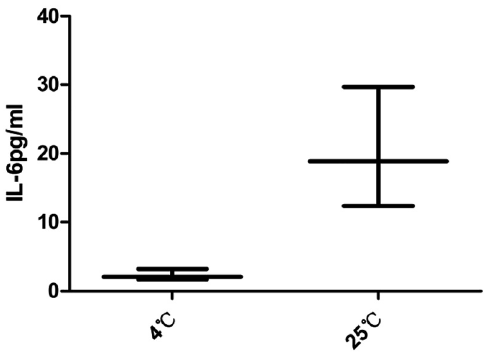
Figure 4: The levels of IL-6 in separate plasma when stored at 4 ° C and 25 ° C after 24